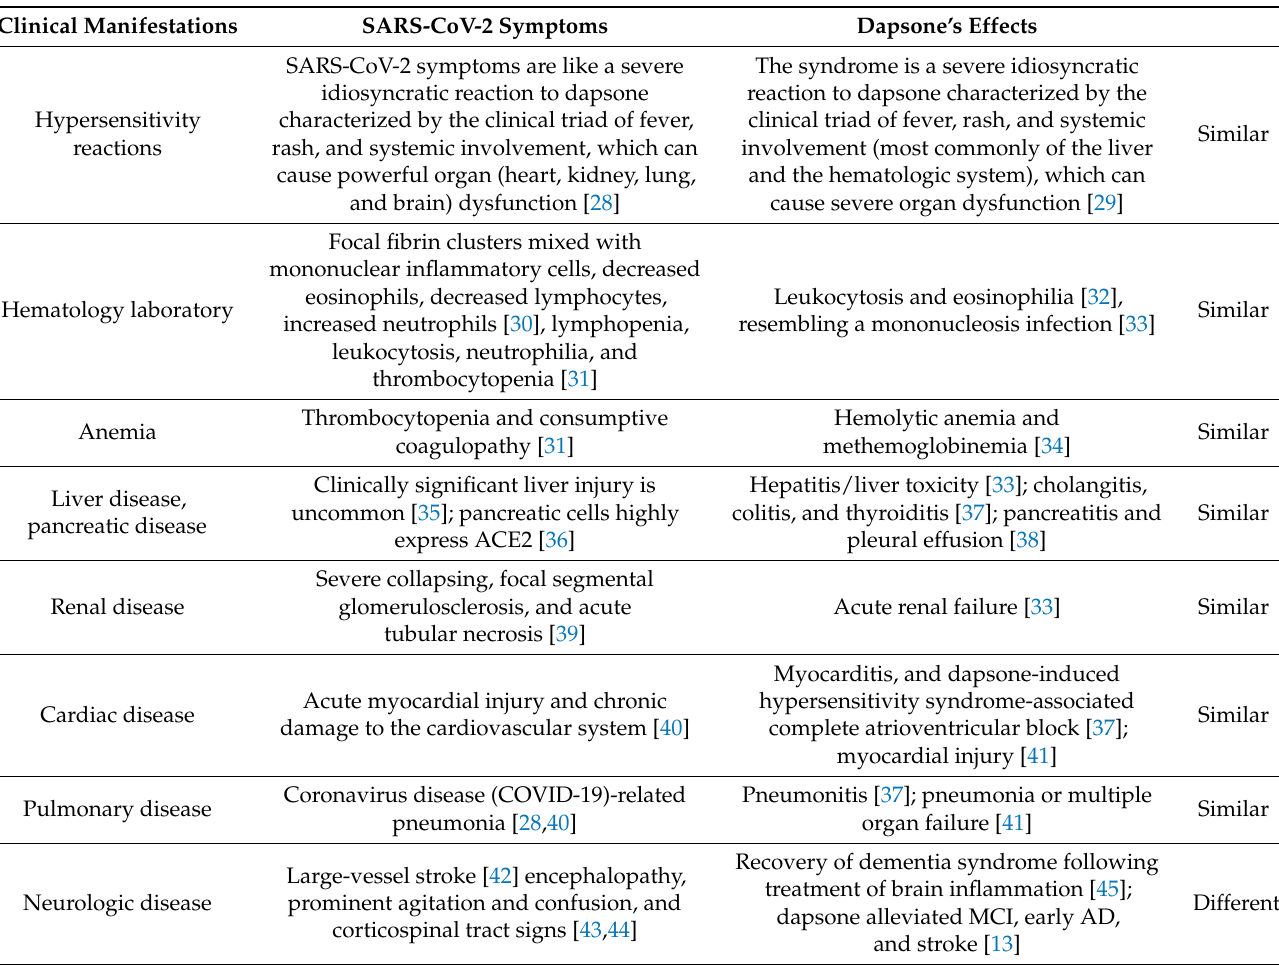
Table 1. The different neurological manifestations of SARS-CoV-2 (cid:48) s and dapsone’s effects in humans. Clinical